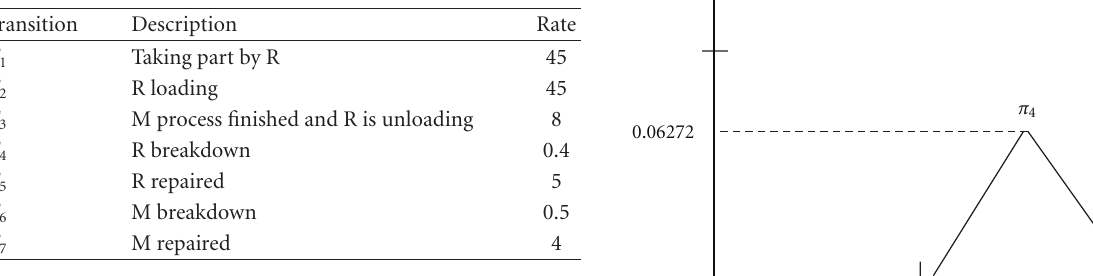
Table 11: Transition firing rates of Figure 7.